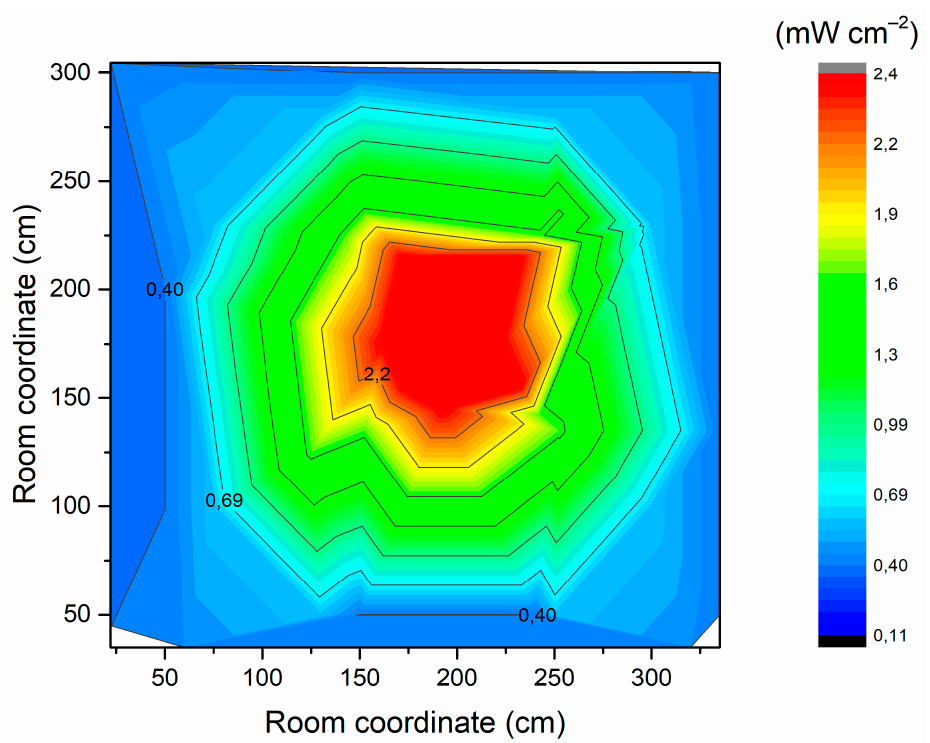
Figure 7. UV-C irradiation inside the